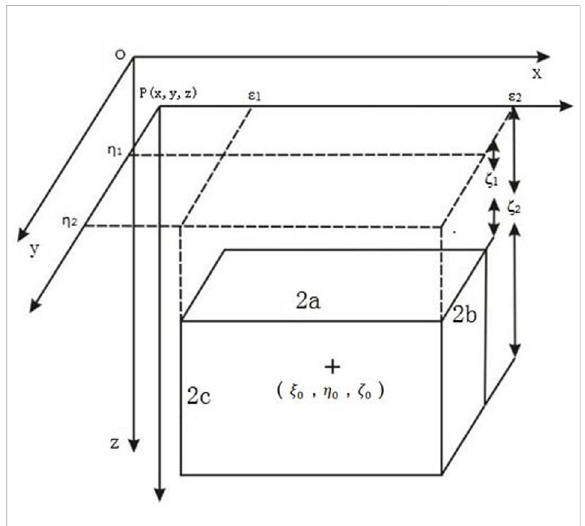
FIGURE 1 Schematic of the coordinate transformation and forward modeling of a vertical